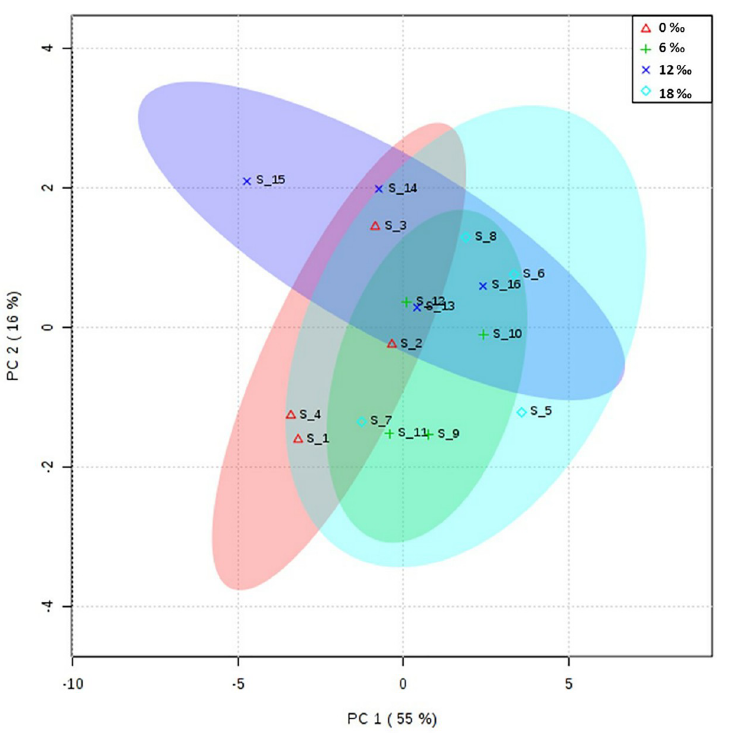
Fig 6. PCA scores plot of fatty acids profiles in the muscles of adult female E. sinensis